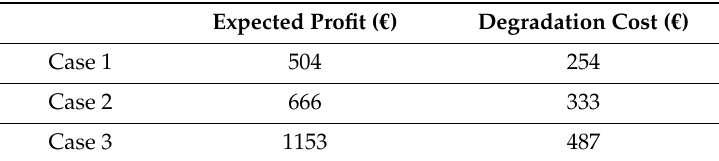
Table 1. Comparison between Case 1, Case 2, and Case